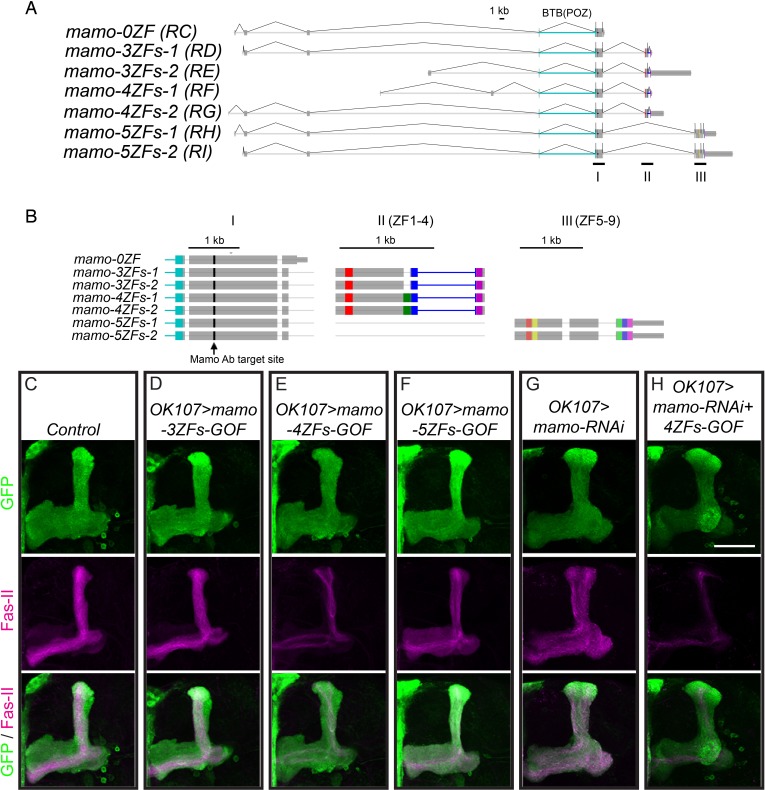
The Mamo variant containing 4ZFs is the prospective isoform acting in α’/β’ temporal fate determination.(A) mamo mRNA isoforms. Gray boxes show UTRs. Cyan labels BTB (POZ) domain at N-terminus, Different colors at C-terminus label zinc finger motifs. (B) Detailed motif descriptions of I, II, and III in (A). The Mamo antibody (Ab) target site (black arrow) is in N-terminus of the common region. There are nine ZF motifs labeled with different colors. (C–H) Adult MBs were immunostained for GFP (green) and Fas-II (magenta). Images are Z-stack projections (standard deviation) of the axon region and are representative of n > 6. Lobes are identified based on both 3D structure as well as marker expression. Scale bar = 50 μm. (D–F) Overexpression of different mamo variants with OK107. mamo-4ZFs-GOF results in altered MB lobe morphology with reduced Fas-II staining (E) compared to control (C). mamo-5ZFs-GOF expands Fas-II staining to a majority of axons. (G–H) mamo variant with 4ZFs rescues mamo-RNAi. Expression of mamo-RNAi induces expanded Fas-II staining (G). mamo-RNAi together with mamo-4ZFs-GOF results in a reduced Fas-II positive lobe, similar to mamo-4ZFs-GOF alone (E).